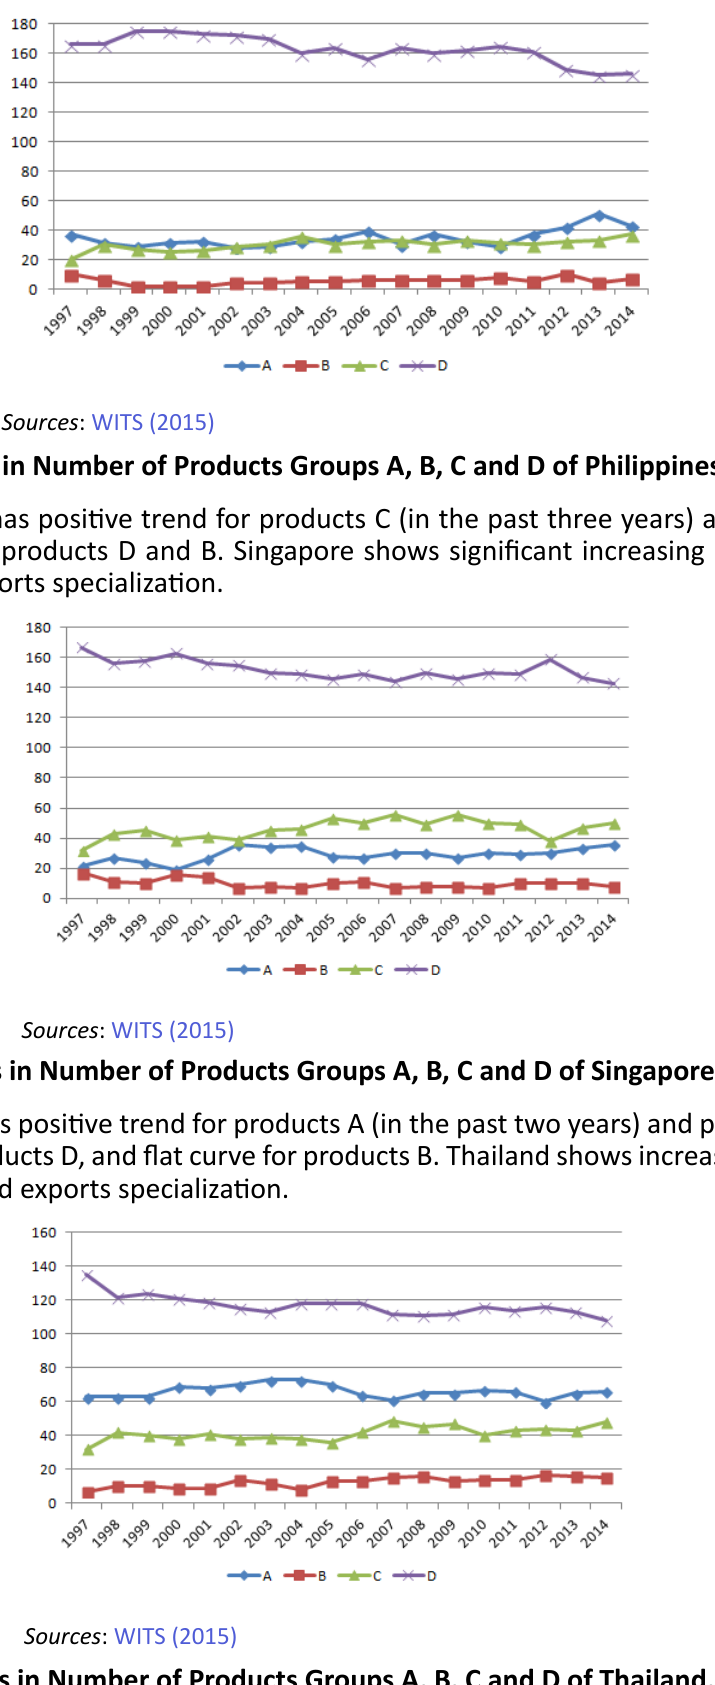
Figure 6: Trends in Number of Products Groups A, B, C and D of Thailand, 1997-2014 Vietnam has positive trend for products B and C, negative trend for products A